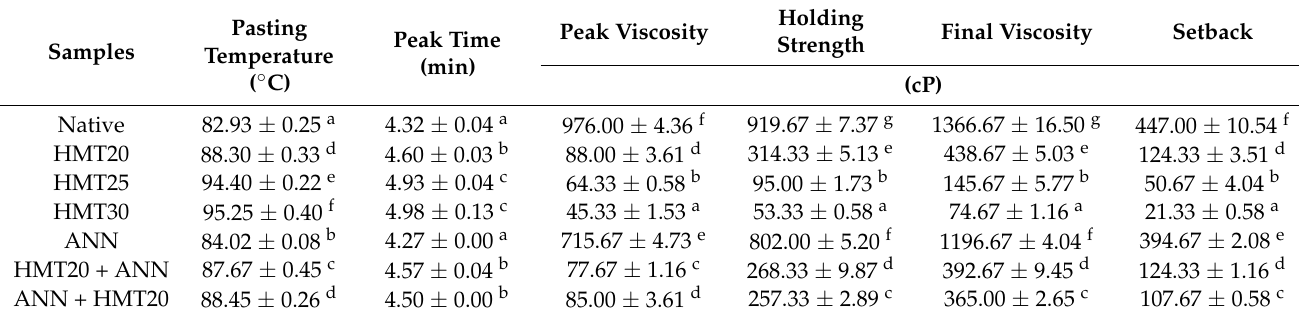
1 Sample codes refer to Figure 1. 2 Each data was expressed as the mean ± standard deviation ( n = 3). Means with different superscript letters in the same column are significantly different ( p <